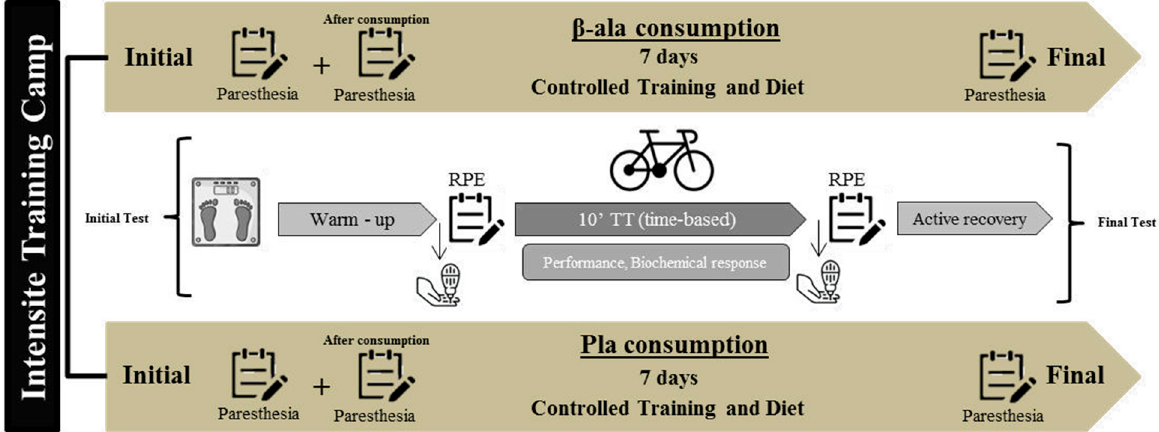
Figure 1. Graphical representation of the study design. RPE: Rating of Perceived Exertion. Inclusion criteria were: (a) male professional active cyclist belonging to a UCI World Team; (b) starting the study in a well-rested condition: not performing intense